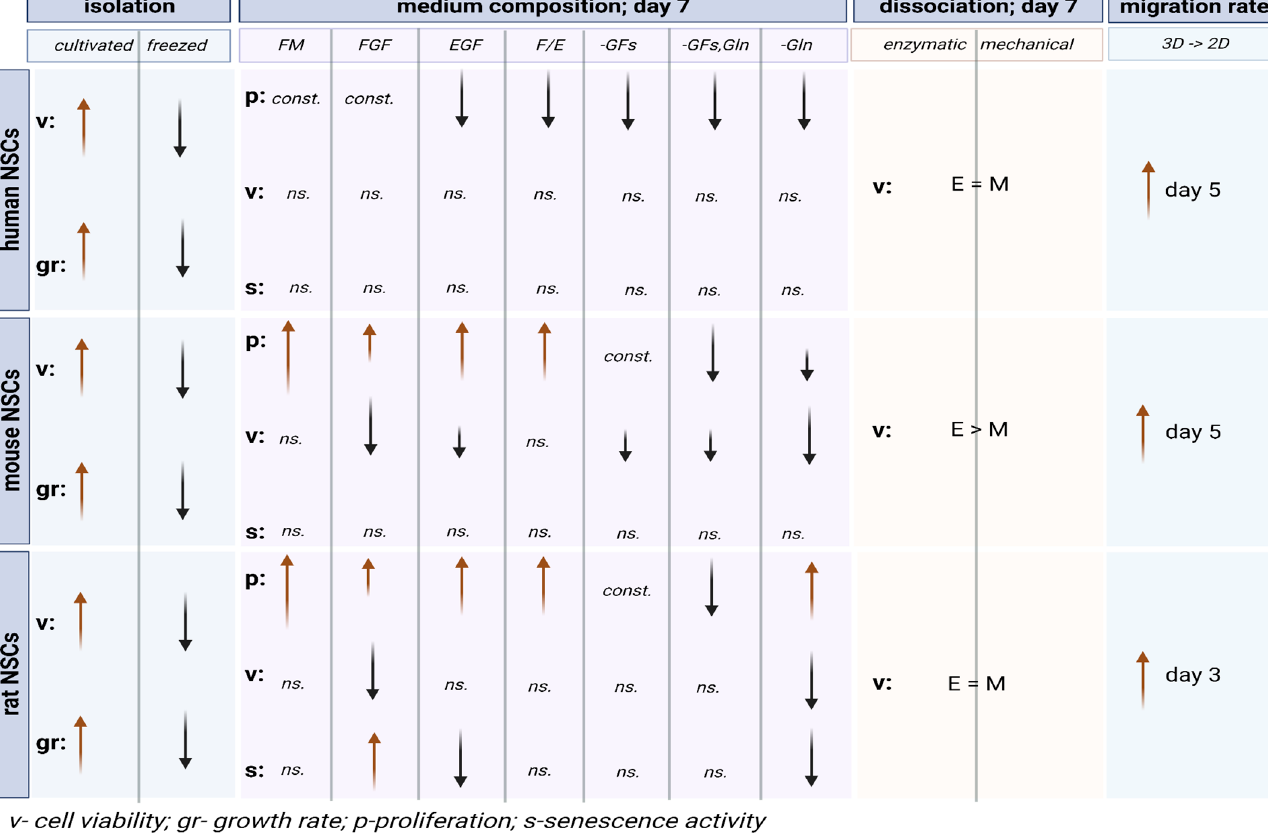
Figure 17. The summary of selected intra-species variability in different culture conditions.